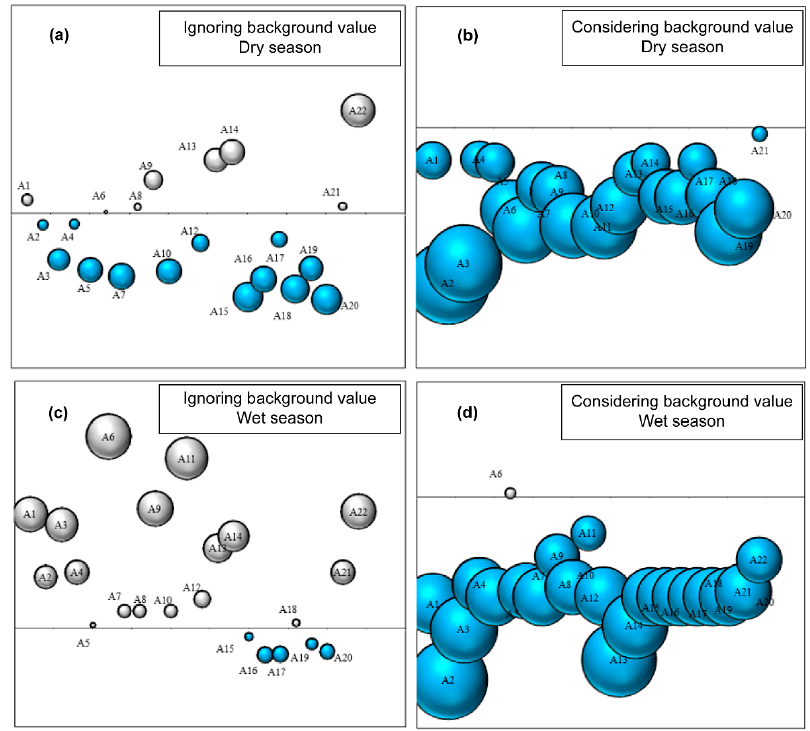
Figure 9. Degree of pollution in 22 source water reserves throughout 2017, ( a ) and ( c ) ignoring and ( b ) and ( d ) considering background values for ( a ) and ( b ) the dry season and ( c ) and ( d ) the wet season. Above the horizontal ordinate, the larger the circle, the greater is the degree of water pollution. Conversely, below the horizontal ordinate, which indicates better water quality throughout the year, the larger the circle, the better is the water quality.